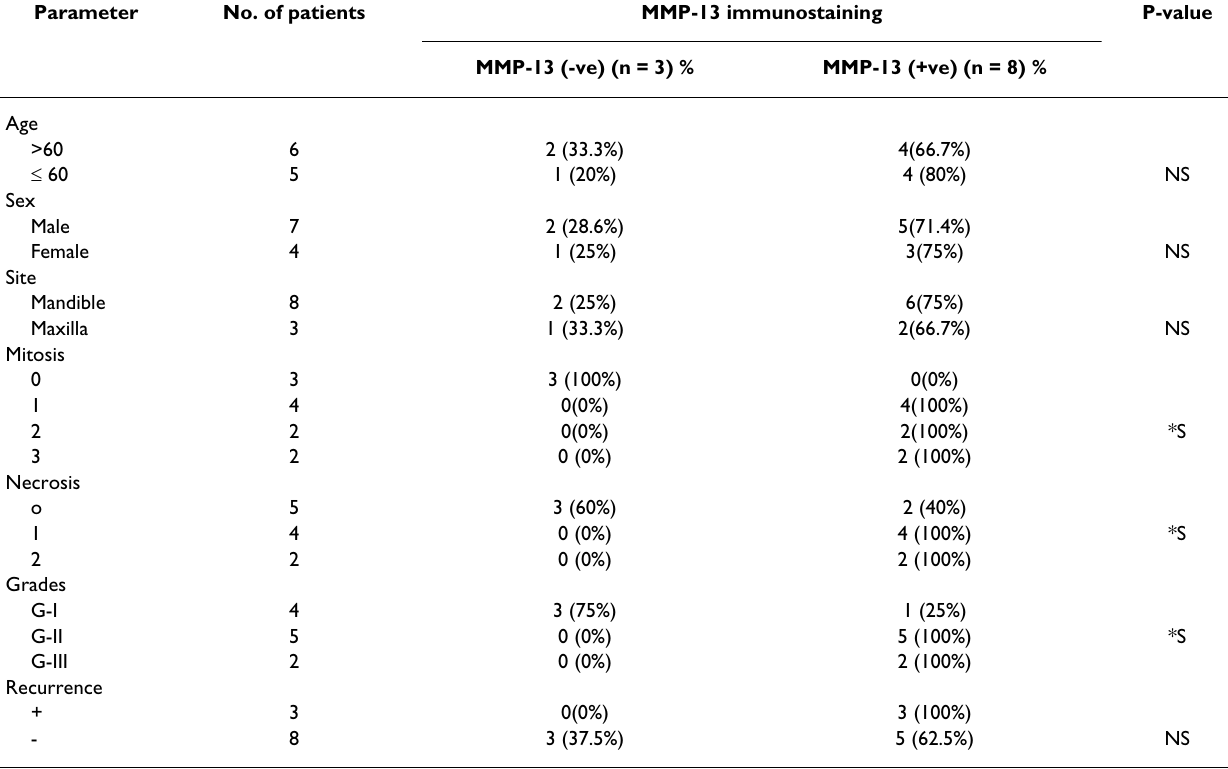
Table 2: Correlation between MMP-13 expression and clinicopathological parameters of chondrosarcoma patients.